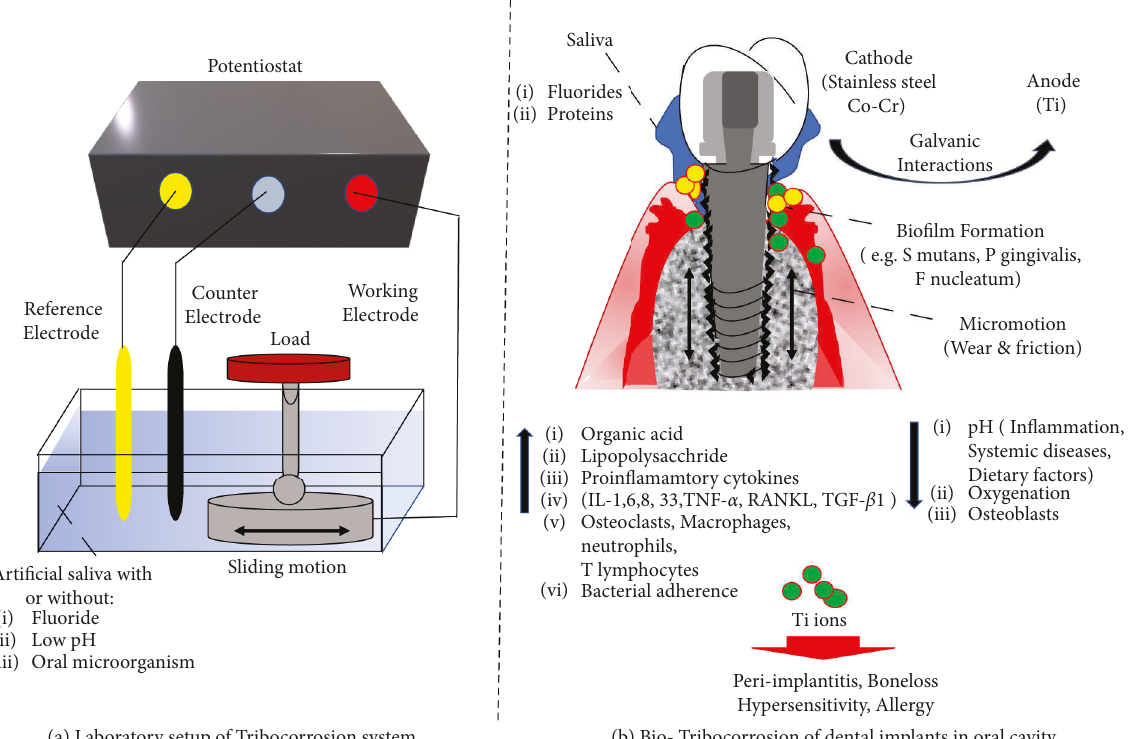
Figure 2: Factors responsible for bio-tribocorrosion of dental implants in oral cavity. (a) Laboratory setup of the tribocorrosion system. (b) Bio-tribocorrosion of dental implants in the oral